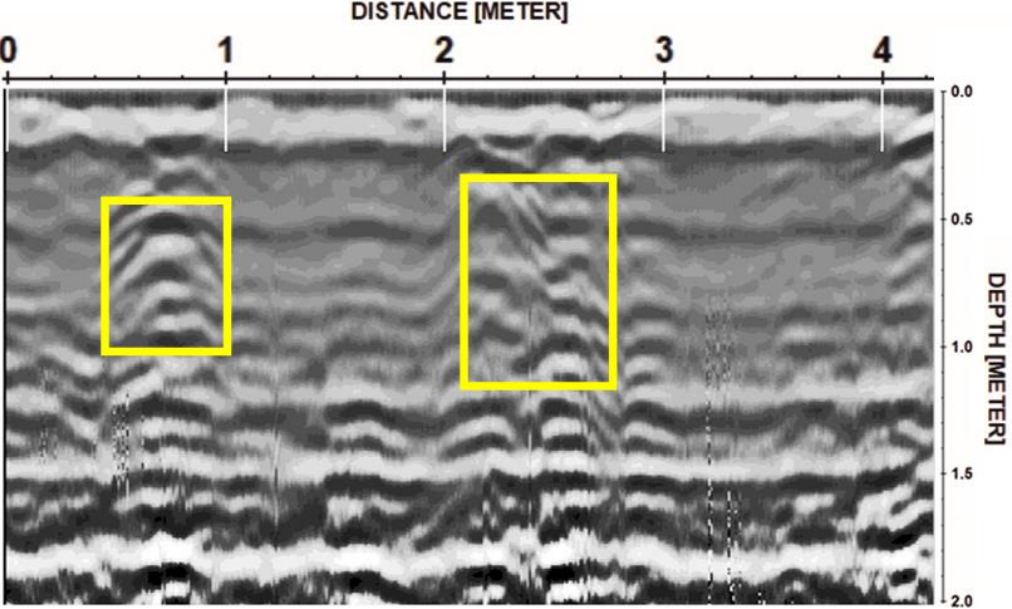
Figure 11. GPR reflection profile from profile 2; GPR 4 area; SIR-3000 device. Yellow rectangle marks anomalous zones.